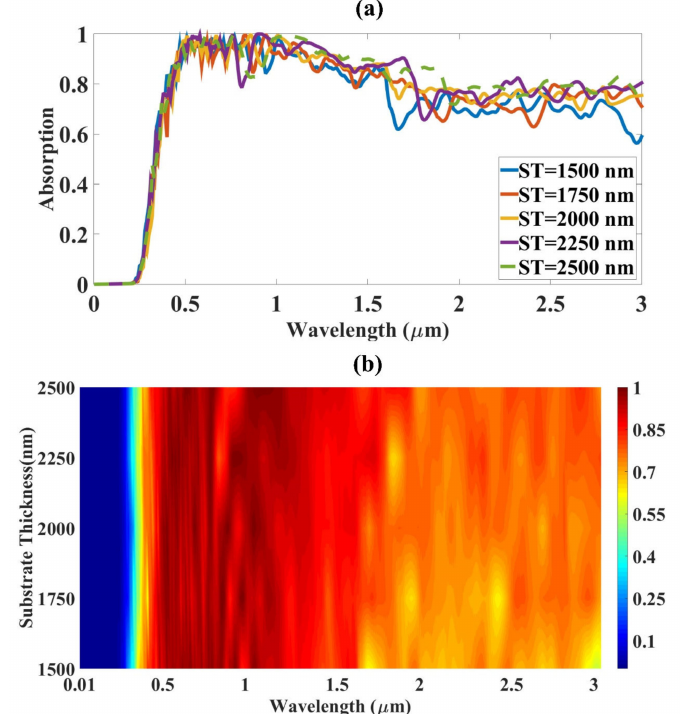
Figure 4. Absorption response for variation in ST (substrate thickness). The variation is carried out from 1500 to 2500 nm with a separation of 250 nm. The absorption spectrum is presented in the form of ( a ) line, ( b ) color plots for the wavelength range of 0 to 3000